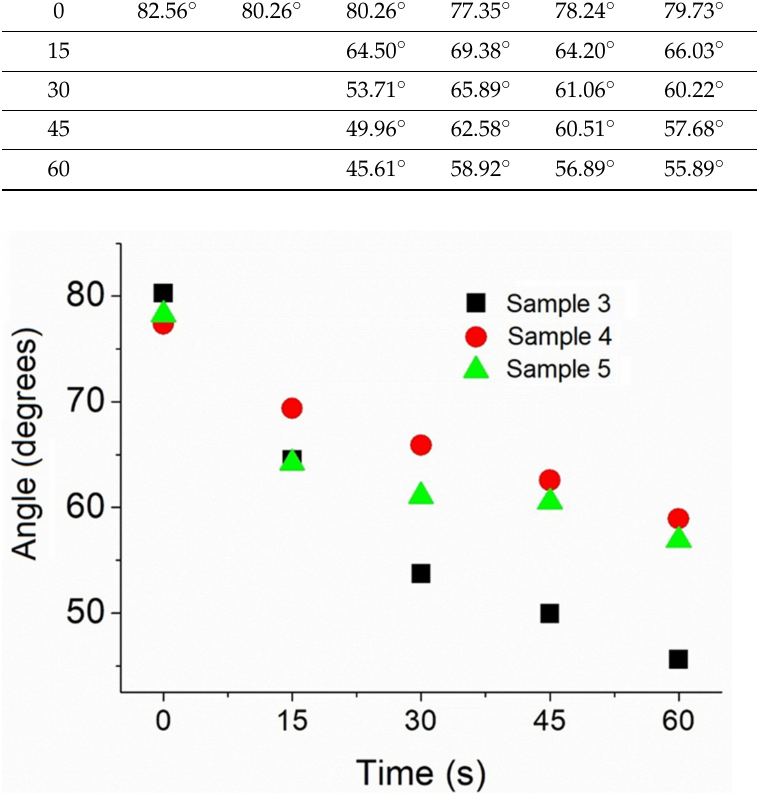
Figure 5. NaCl drop contact angle with the surface of samples 3, 4, and 5 as a function of time after drop deposition. The contact angle with the surface of samples 1 and 2 was measured only at t =